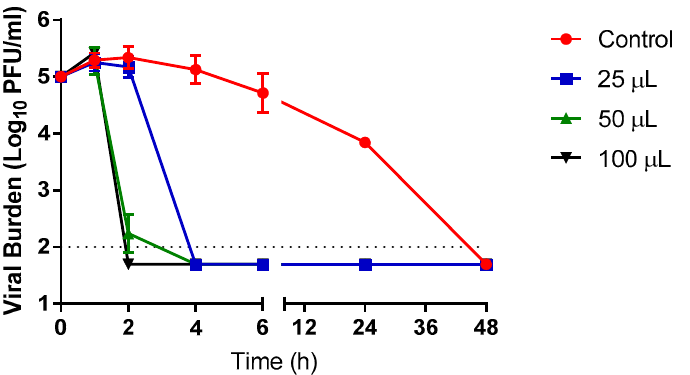
Figure 3. The effect of various volumes of liquid Propylamylatin formula on the ability of vapors to inactivate infectious SARS-CoV-2. A suspension of 10 5 PFU of SARS-CoV-2 was exposed to vapors resulting from 25, 50, or 100 µ L aliquots of liquid Propylamylatin formula and incubated at 37 ◦ C. At various times post-Propylamylatin-formula vapor exposure, viral suspensions were harvested, and viral burden was quantified by plaque assay in Vero E6 cells. Viral burden is reported as log 10 PFU/mL. Data points correspond to the geometric mean of two independent samples and error bars represent one standard deviation. The horizontal dashed line signifies the plaque assay limit of